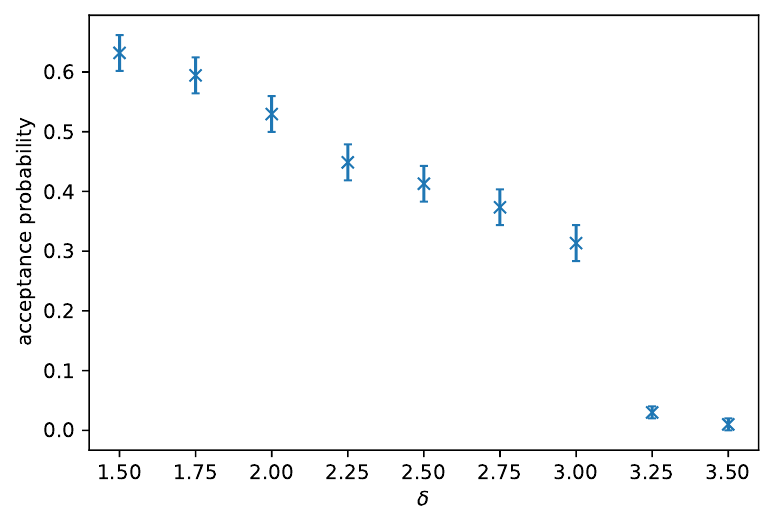
Figure 7. Probability of a proposal being accepted for τ = 1 . Note that while acceptance probability decreases with step size, the ‘speed’ around the manifold increases as the larger step size